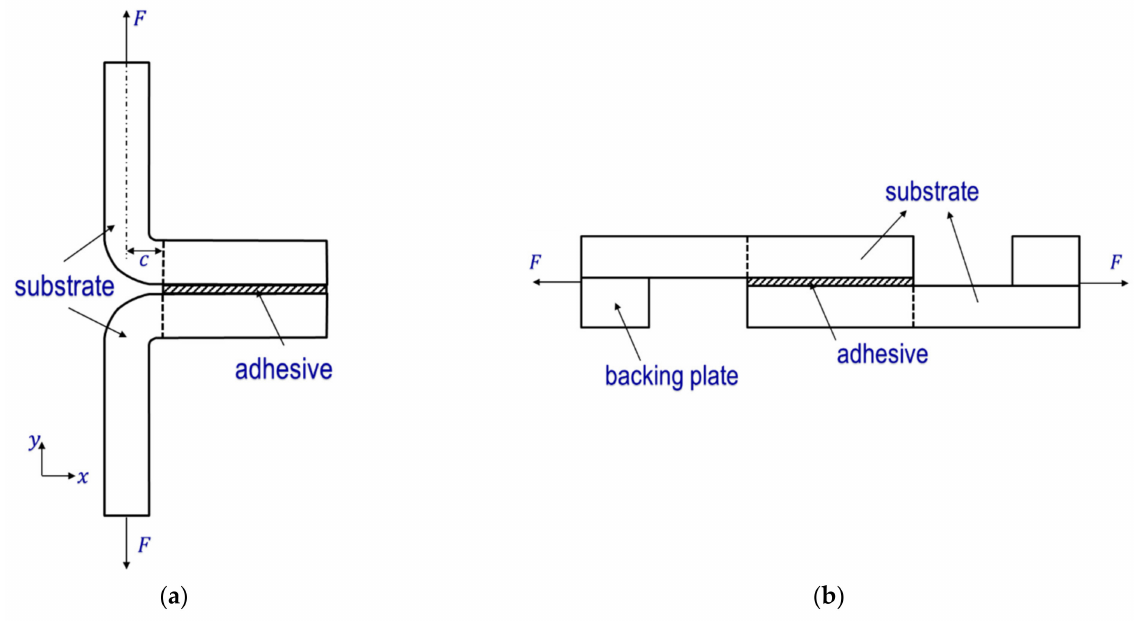
Figure 1. Two commonly used fatigue test specimens for adhesive joints. ( a ) Coach-peel. ( b ) Lap-shear.